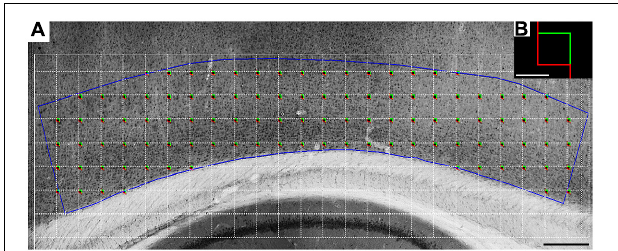
FIGURE 2 | A representative low-power photomicrograph of a rat Egr-1-immunolabeled section of the somatosensorial infragranular cortical layers. (A) Blue line contour shows the border of the region of interest in a sagittal section. The white grid indicates the intervals between the square red/green boxes (shown larger in panel B ) and shows the systematic random sampling approach. The total number of counting boxes in each section was proportional to the area covered by the somatosensory cortex infragranular layers. The antero-posterior limits of the contour were drawn using lines orthogonal to the pia mater. These lines originated at the border of the underlying hippocampal pyramidal cell layer. Because the area and the volume inside the contours could change within and between experimental groups, we estimated and compared volumetric cell densities rather than the total number of cells. Scale bar, 300 µ m (A) , 20 µ m (B)